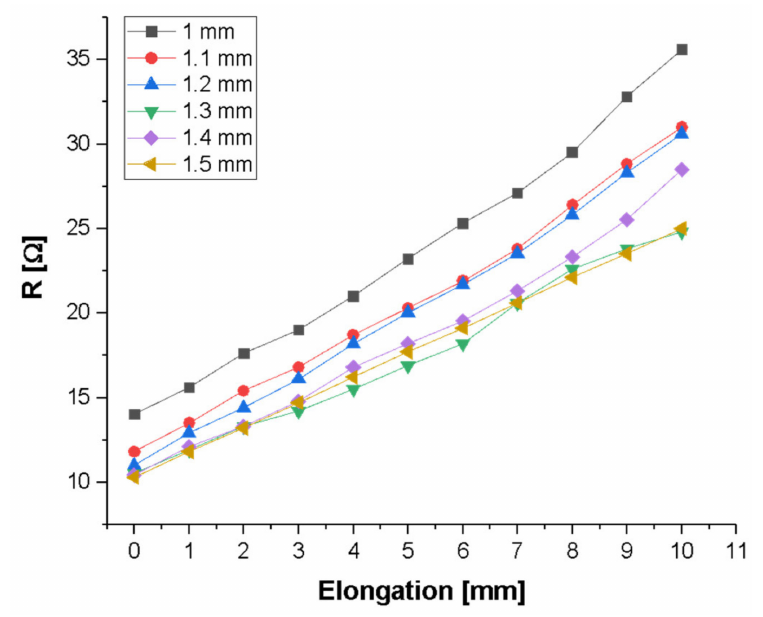
Figure A7. Resistance variation of each pattern of the Inkron IPC-603X screen-printed ink on the DelStar EU50 substrate according to the elongation.